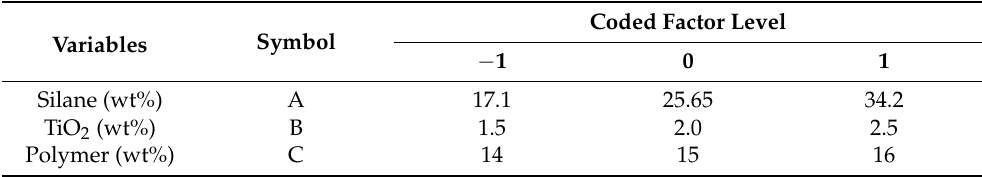
Table 3. Coded and actual values of variables for the experiment.